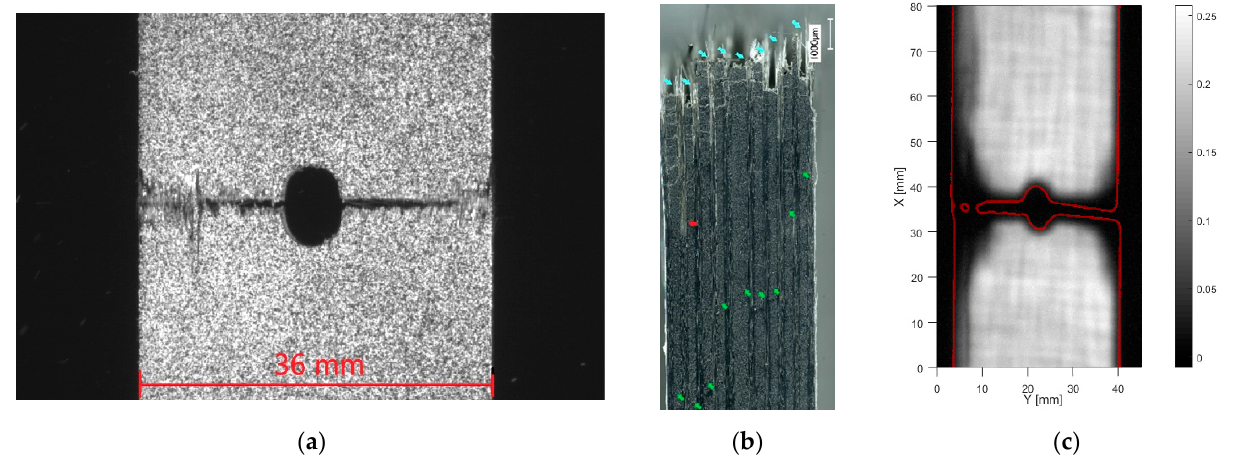
Figure 5. Tensile failure of [0/90] 5s . ( a ) front view, ( b ) side microscopy, ( c ) through transmission ultrasound (for high resolution, please refer to the online version of this article).